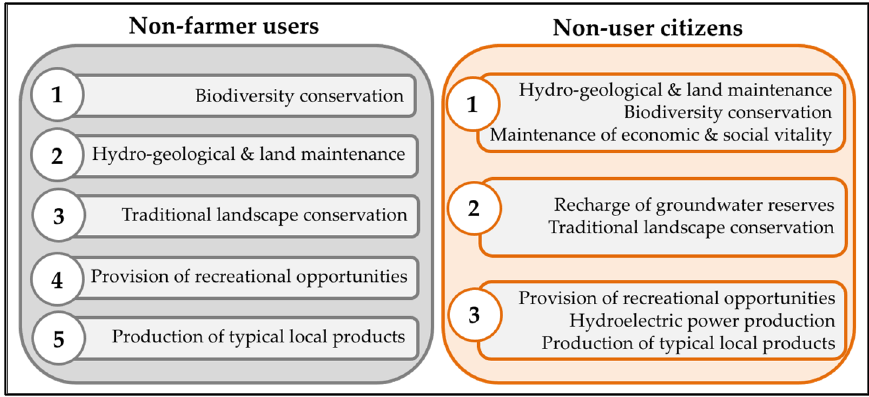
Figure 2. Benefits ranked based on question Q2.